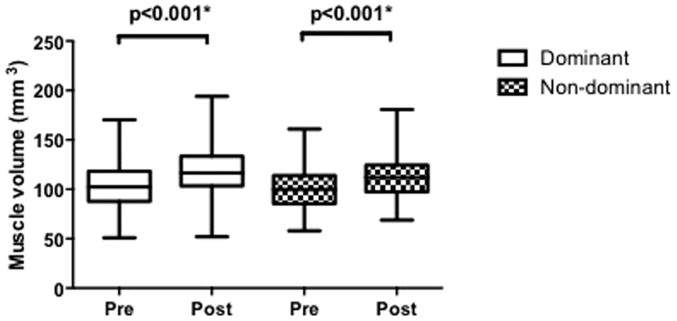
Change in rectus femoris muscle volume with military training, in dominant and non-dominant limbs.* denotes p < 0.05. Box and Whisker plots are of median and range.